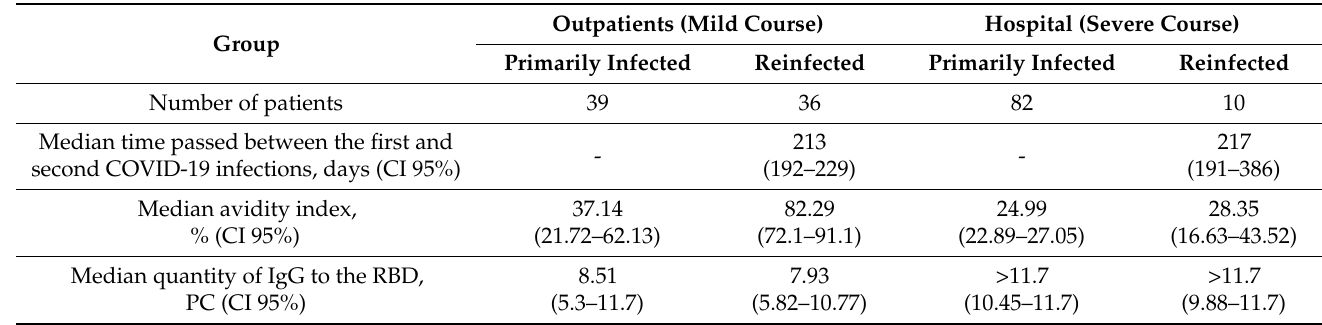
Table 1. Data for the studied groups of outpatients (with mild course of COVID-19) and hospitalized patients (with severe course) who were primarily or secondarily infected with COVID-19. The confidence intervals (CIs) are shown in